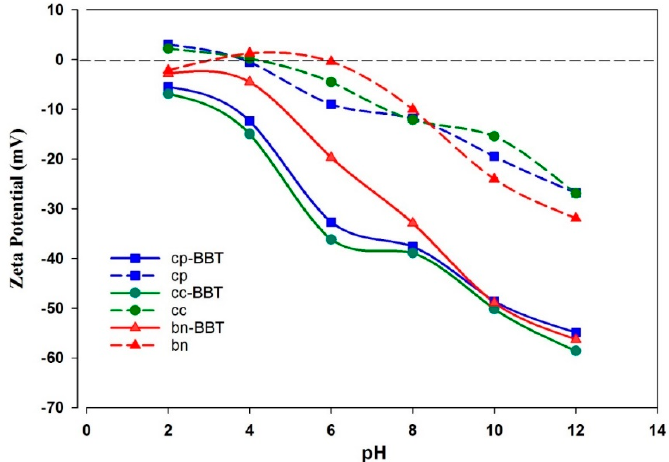
Figure 1. Zeta potential of copper minerals in n -Butoxycarbonyl-O- n -butyl thionocarbamate (BBT) and an aqueous solution as a function of pH at collector concentration 4 × 10 − 5 M. cp-chalcopyrite, cc- chalcocite,